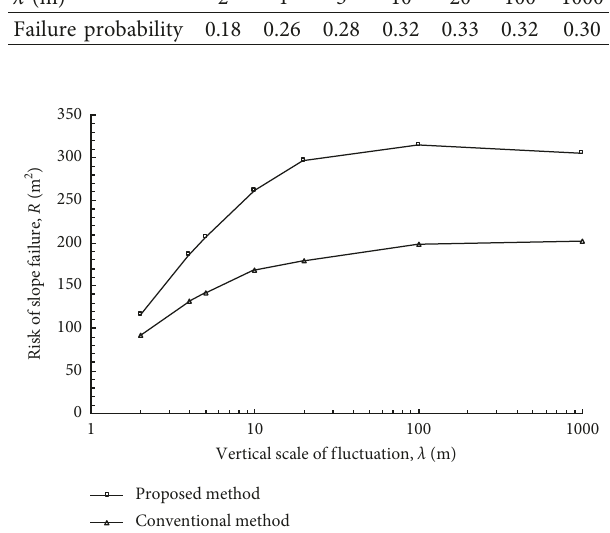
Figure 10: Effect of vertical scale of fluctuation of S failure risk for the cohesive